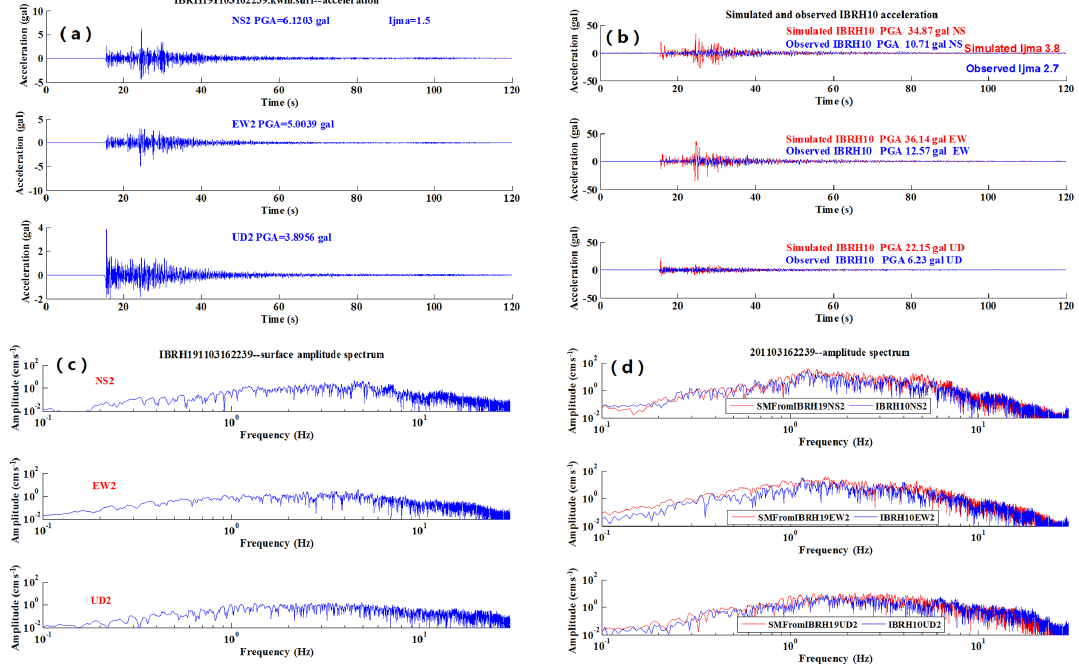
Figure 11. An example of simulation from IBRH19 (surface) to IBRH10 (surface) for the earthquake 201103162239: (a) the observed surface acceleration for IBRH19, (b) the observed surface acceleration waveform (blue) compared with the simulated one (red), (c) the spectral ratio of observed surface record for IBRH19, and (d) the observed spectra of surface record at IBRH10 (blue) compared with the simulated one